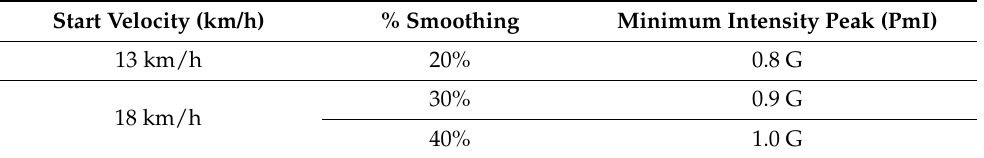
Table 1. Modifiers parameters of the algorithm.